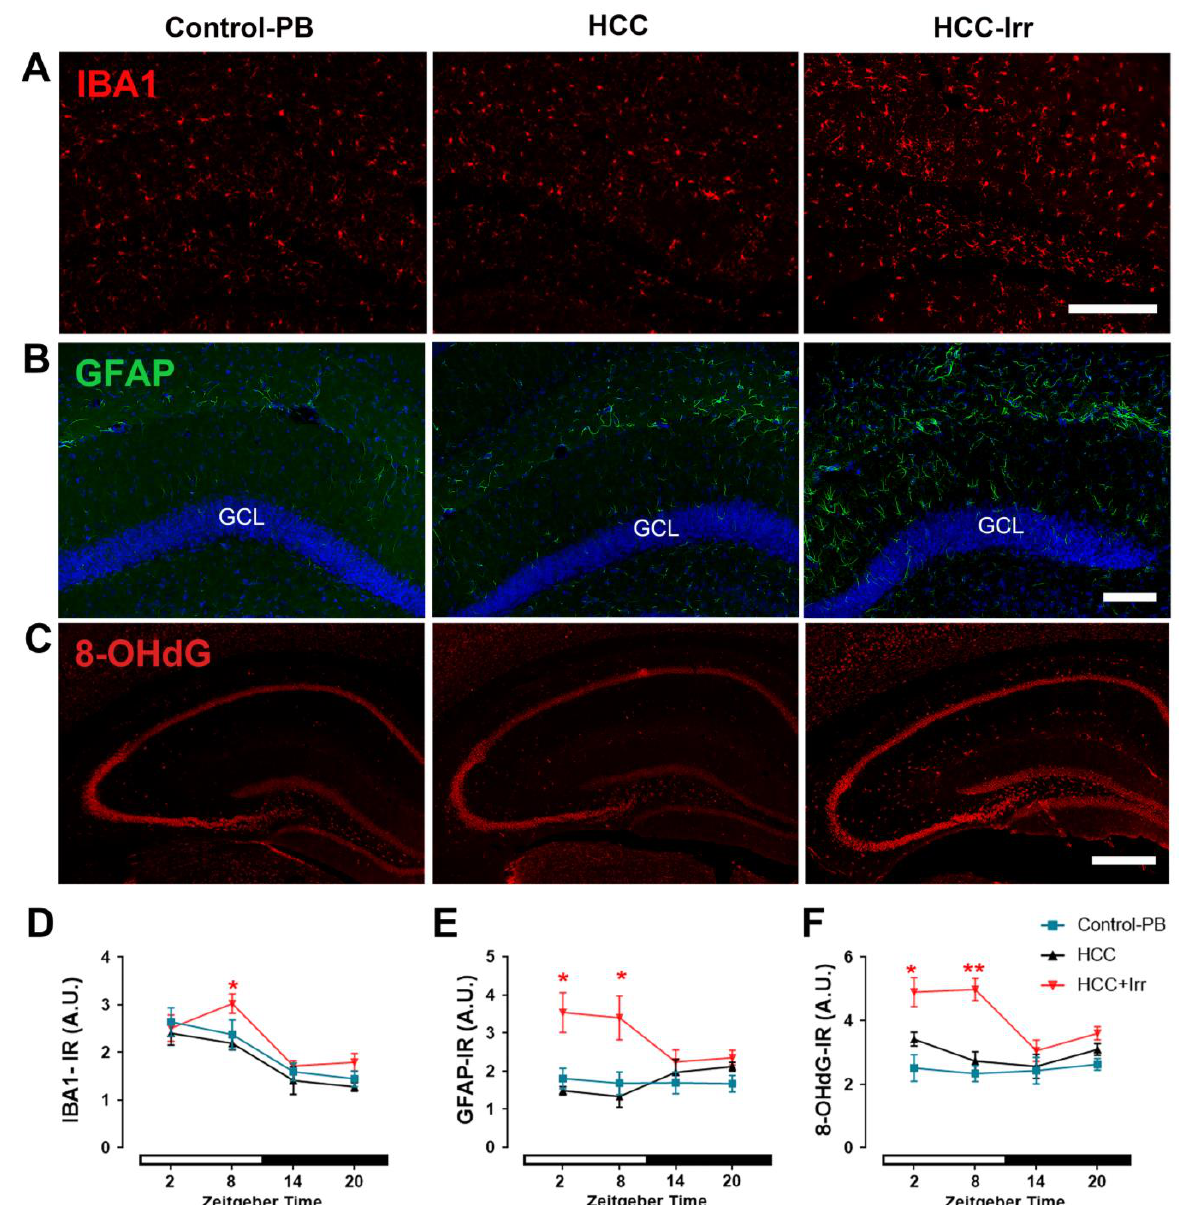
Figure 2. Effect of HCC and radiotherapy on glial activation and oxidative stress in the mouse hippocampus. ( A ) Representative photomicrographs of mouse hippocampal sections showing the immunoreaction (IR) of the microglial marker IBA1 (red) at ZT08 in control-PB, HCC and HCC+Irr mice. ( B ) Representative photomicrographs of mouse hippocampal sections showing IR of astrocytic marker GFAP (green) and nuclear staining DAPI (blue) at ZT08 in control-PB, HCC and HCC+Irr mice. ( C ) Representative photomicrographs of mouse hippocampal sections show IR of oxidative stress marker 8-OHdG (red) at ZT08 in control-PB, HCC and HCC+Irr mice. ( D ) Quantification of microglial activation assessed by IBA1-IR. ( E ) Quantification of astrocytic activation by GFAP-IR. ( F ) Quantification of oxidative stress by 8-OHDG-IR. Red asterisks indicate differences between HCC and HCC+Irr. *: p < 0.05, **: p < 0.01. White and black bars indicate the day/rest phase and night/activity phase, respectively. n = 12 mice per group, 3 mice at each time point, 2 sides per animal. Scale bar = 100 µm in ( A , B ); = 200 µm in ( C ). Control-PB: control mice given phenobarbital (PB) in drinking water. HCC: HCC-bearing mice. HCC+Irr: HCC-bearing irradiated mice. Glial fibrillary acidic protein (GFAP). 8-hydroxydeoxyguanosine (8-OHdG). Granular cell layer (GCL).